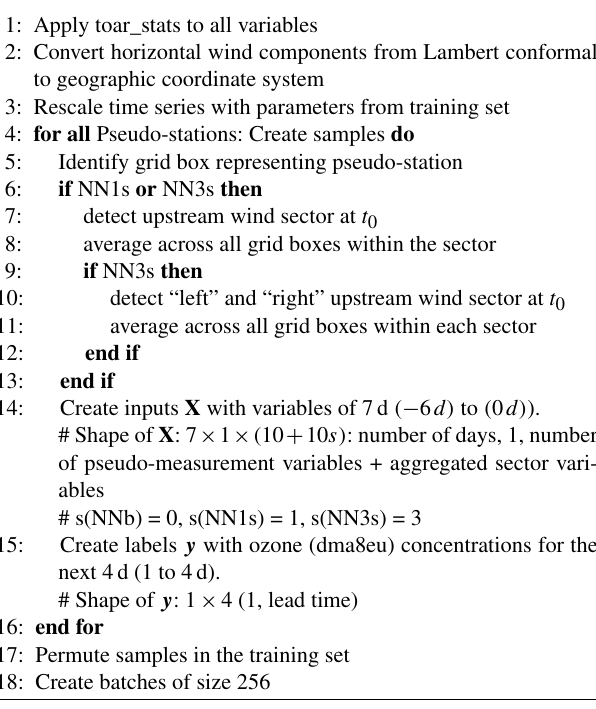
Algorithm 1 Data preprocessing: NNb, NN1s,